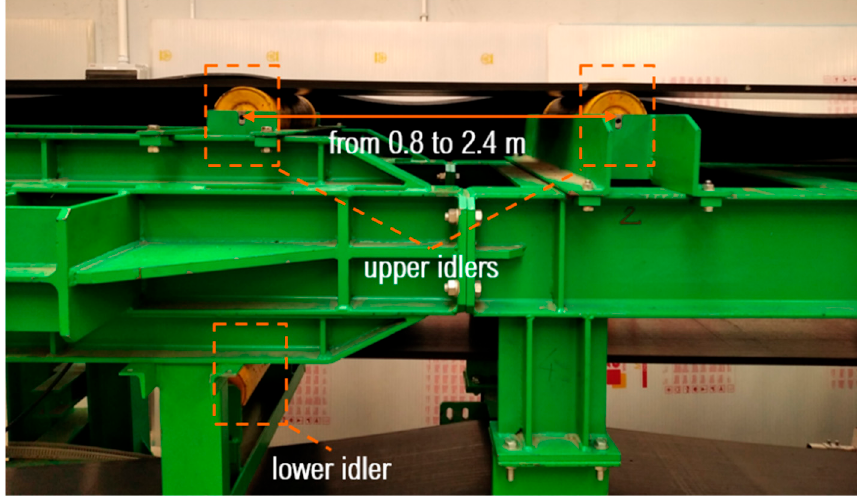
Figure 1. The test rig with indicated locations of idler supports in the upper strand.